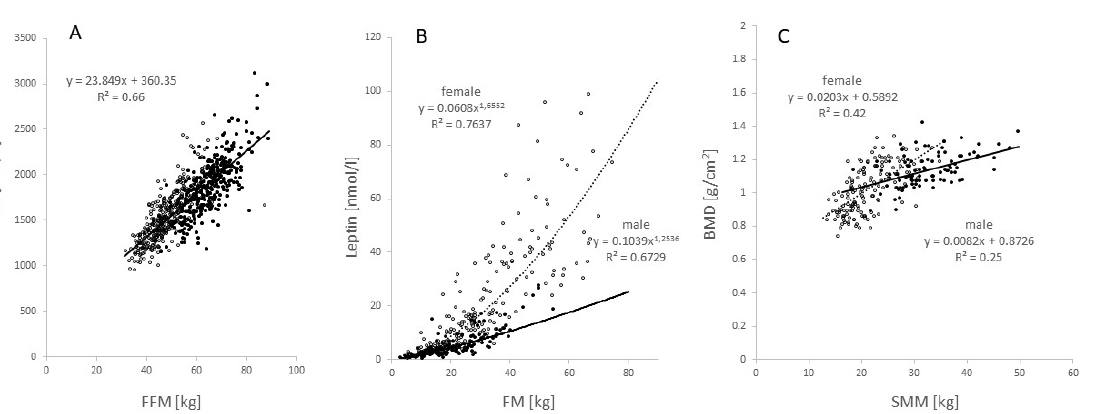
Figure 8. Functional body composition: ( A ) REE on fat free mass (FFM; n = 364 females and 320 males); ( B ) plasma leptin levels (Lep) on fat mass (FM; n = 178 females and 174 males); and ( C ) bone mineral density (BMD) on skeletal muscle mass (SMM; n = 149 females with 33.5% at age >40 yrs and 93 males with 22.5% at age >40 yrs). Subpopulations were taken from the ‘Kiel study population’ (see Methods). Table 4. Resting energy expenditure of the 2021 Reference Body for males and females according to BMI categories, sex and age (of <40 yrs and >40 yrs ). See Methods or details for the ‘Kiel study pop- ulation’ and the calculation of the data.